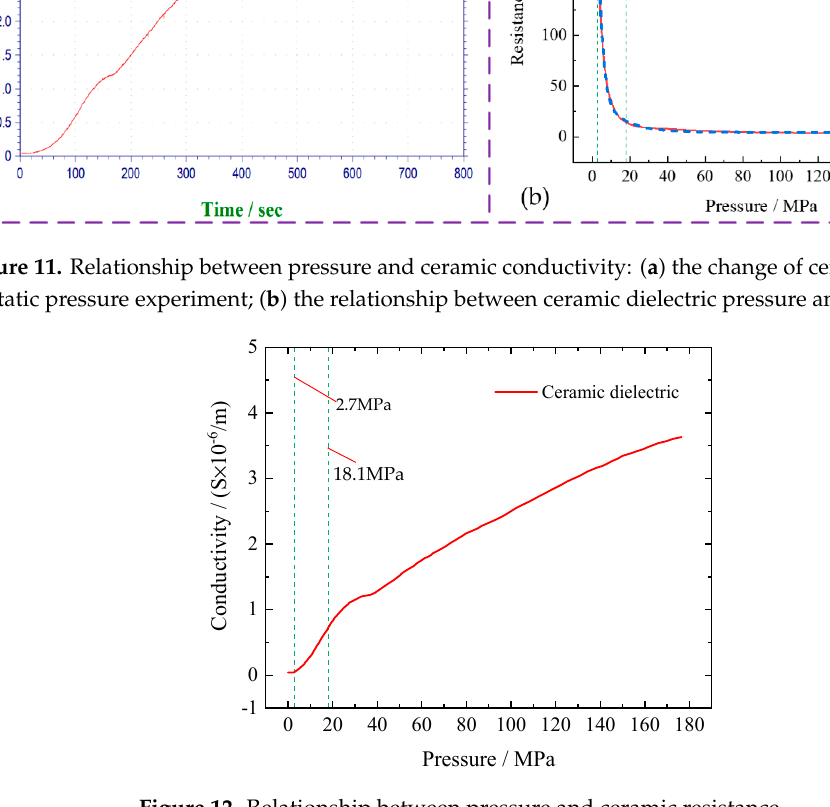
Figure 12. Relationship between pressure and ceramic resistance.